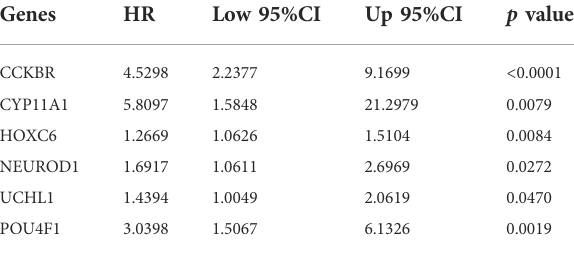
TABLE 1 Univariate COX regression analysis of 6 exosome-related genes in training set.